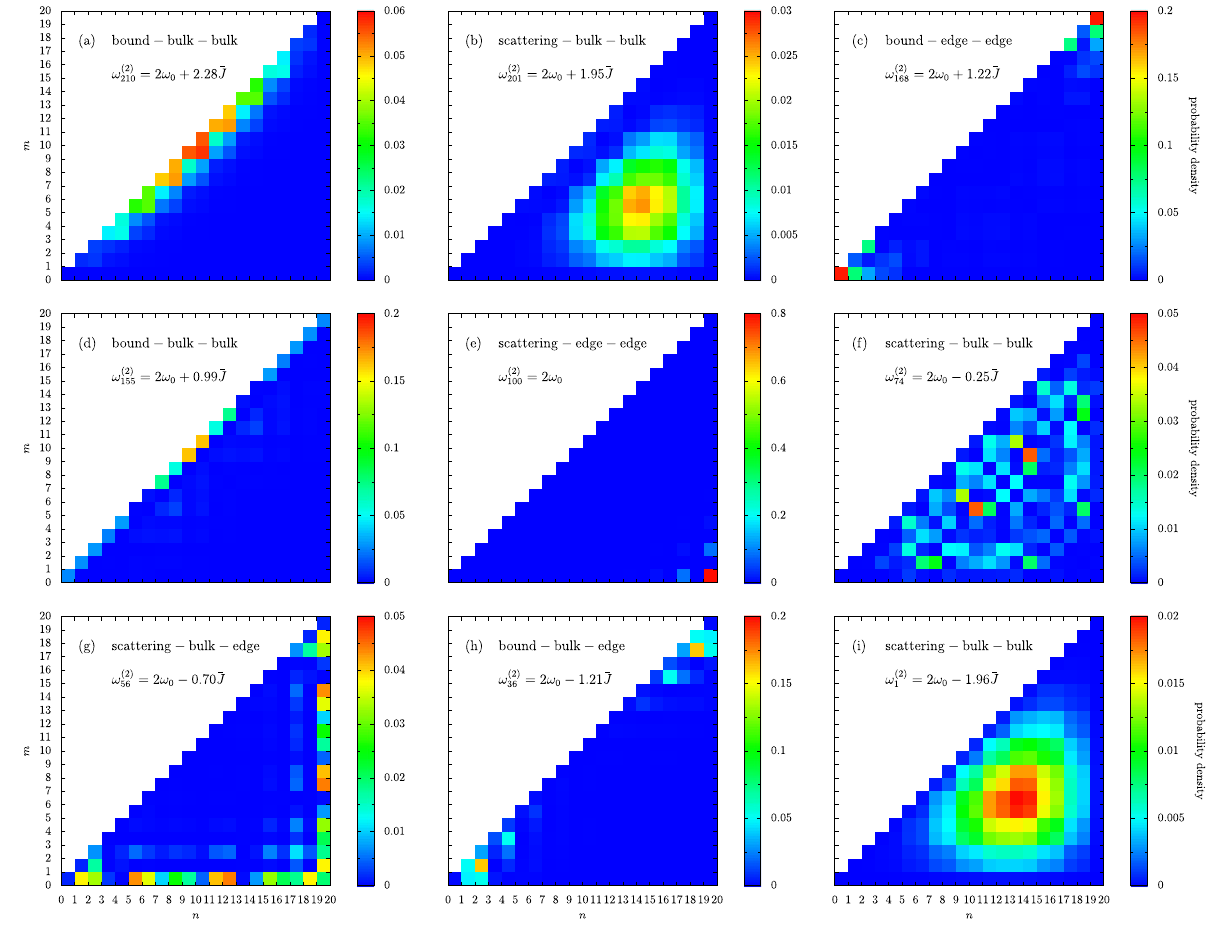
Figure 5. Nine typical eigenstates of a dimerized chain in the two excitation sector, with nonzero interactions J ). Color bars: probability densities (note: the scale is different for each panel). In the figure, the (here, U = ¯ 10 dimers, leading to a 210-dimensional 1 / 2 and the chain is composed of N dimerization parameter ǫ = = − Hilbert space. This regime corresponds to descending the thin, gray vertical line in Fig.